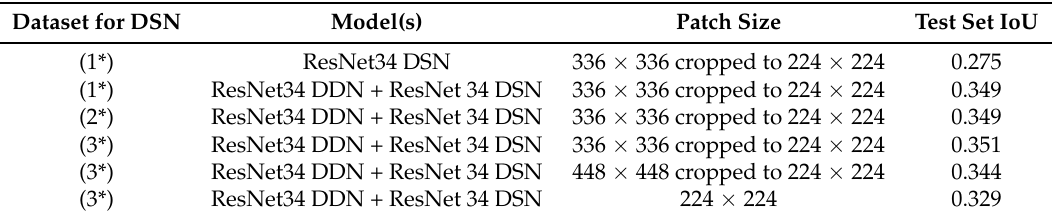
Table 2. Test set IoUs for different patch sizes and data sampling strategies on the reduced training set. Dataset for